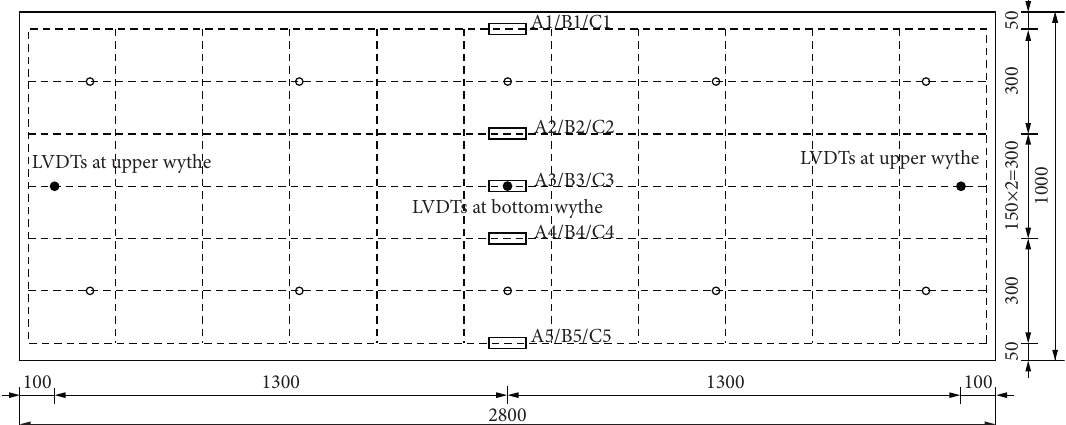
Figure 5: Strain gauge arrangement on the steel reinforcements and LVDT arrangement on the wythes (units: mm).